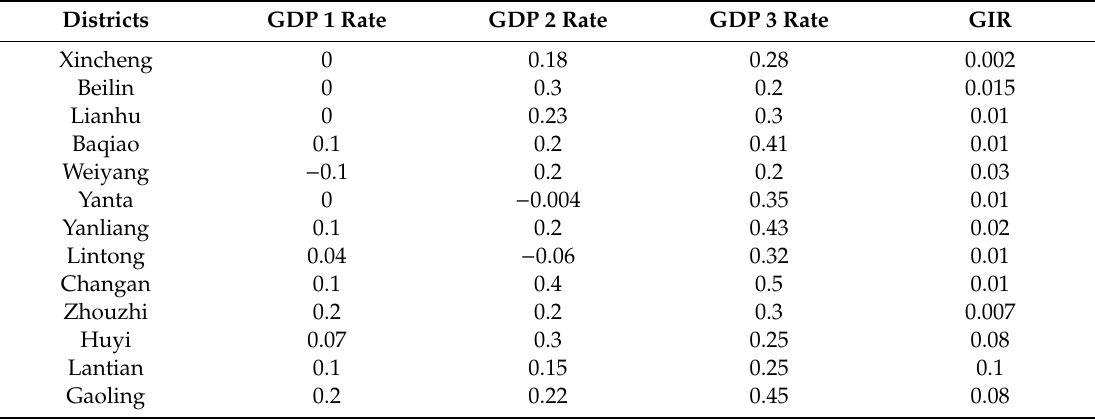
Table A4. Parameter setting of economic priority